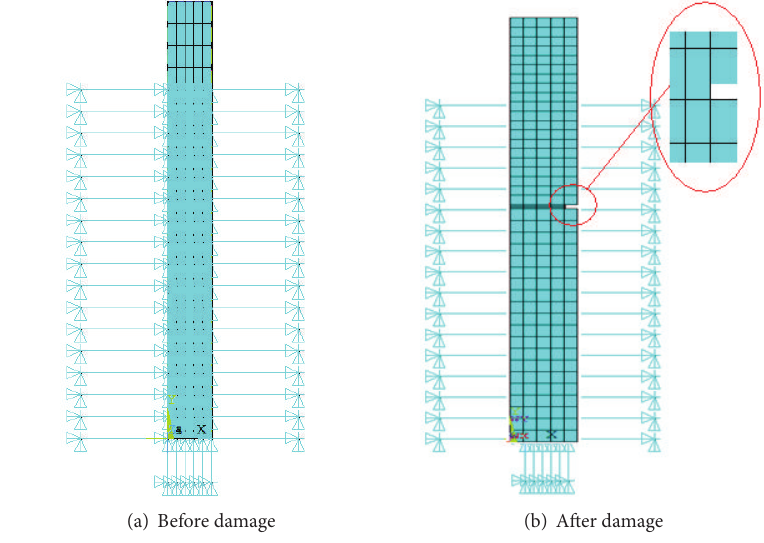
Figure 5: Finite element model of pile-soil interaction.